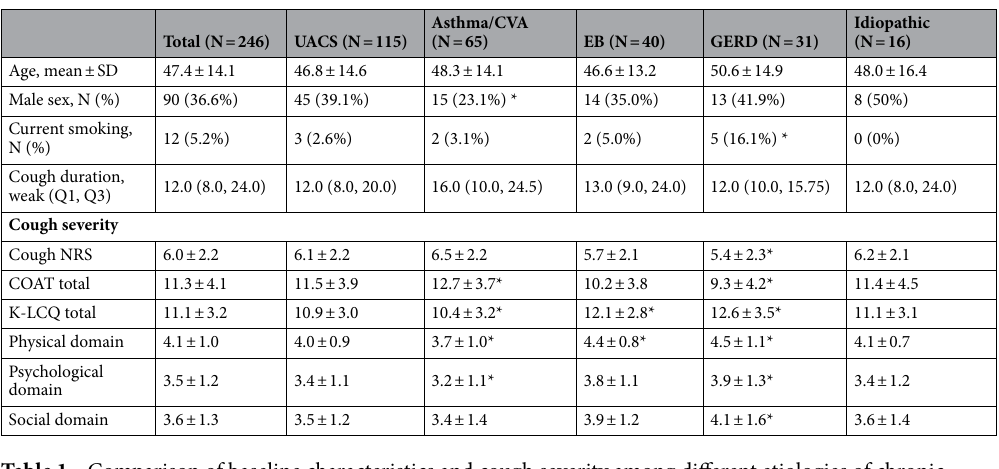
Table 1. Comparison of baseline characteristics and cough severity among different etiologies of chronic cough. UACS upper airway cough syndrome, CVA cough variant asthma, EB eosinophilic bronchitis, GERD gastro-esophageal reflux disease, NRS numeric rating scale, COAT COugh Assessment Test, K-LCQ Korean version of Leicester Cough Questionnaire. *Indicate statistical significance ( p <